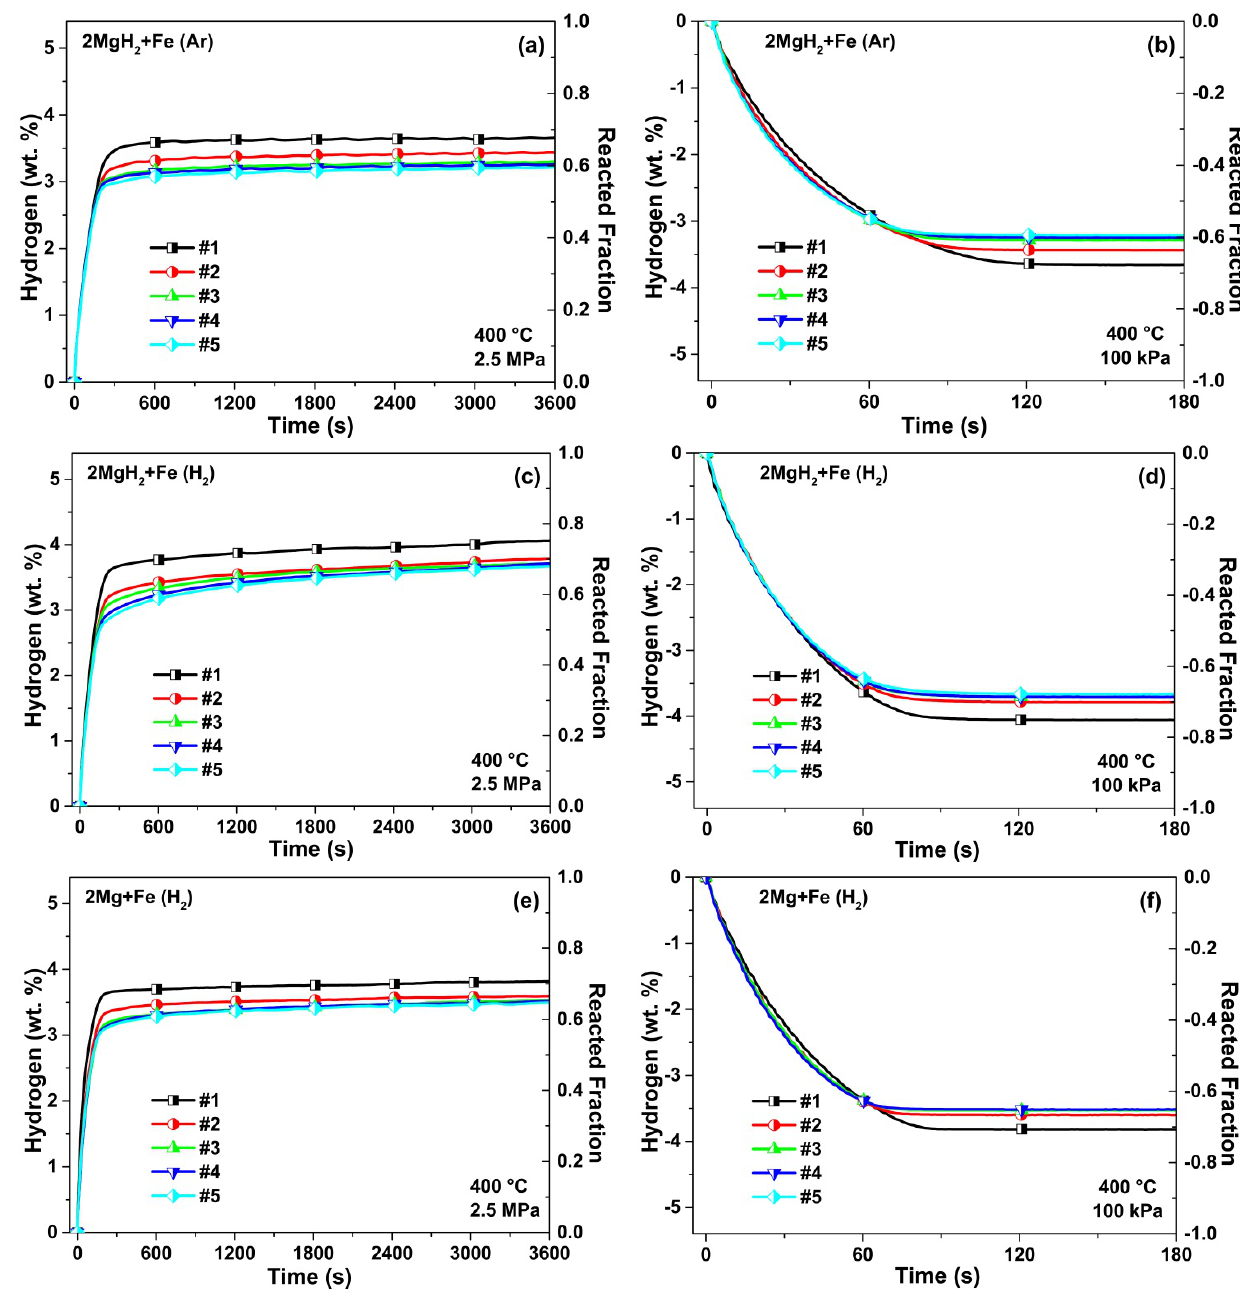
Figure 4. Kinetic curves of hydrogen absorption and desorption at 400 °C of ball milled samples: ( a ) and ( b ) 2MgH + Fe (Ar); ( c ) and ( d ) 2MgH 2 ). The hydrogen absorption and desorption were respectively measured ( f ) 2Mg + Fe (H 2 under 2.5 MPa and 100 kPa of H 2